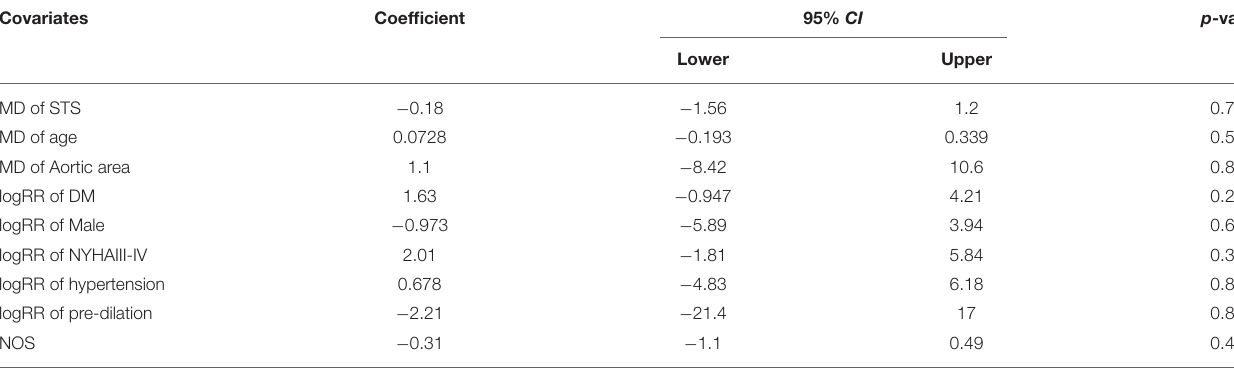
TABLE 6 | Meta-regression analysis using potential confounding factors for post-TAVR PPI in the comparison of type 1 BAV to type 0. Covariates Coefficient